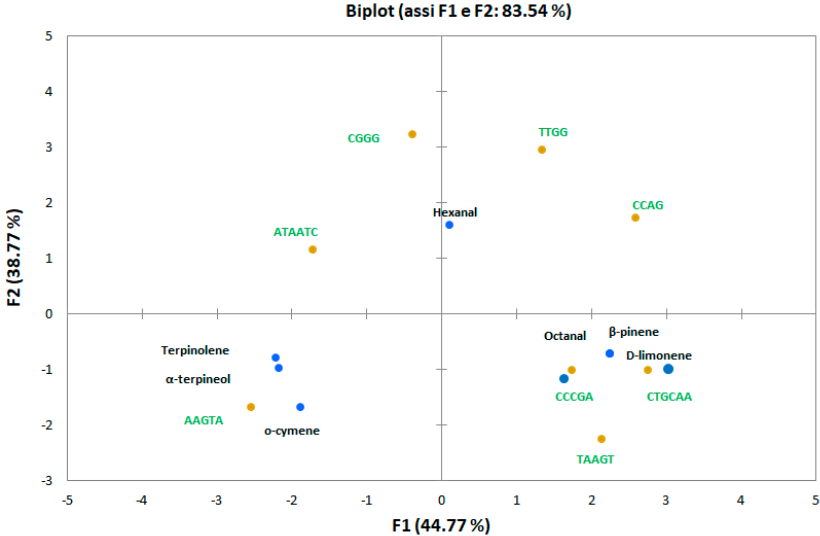
Figure 2. PCA biplot (score and loading) of the normalized quartz crystal microbalance (QCM) response.